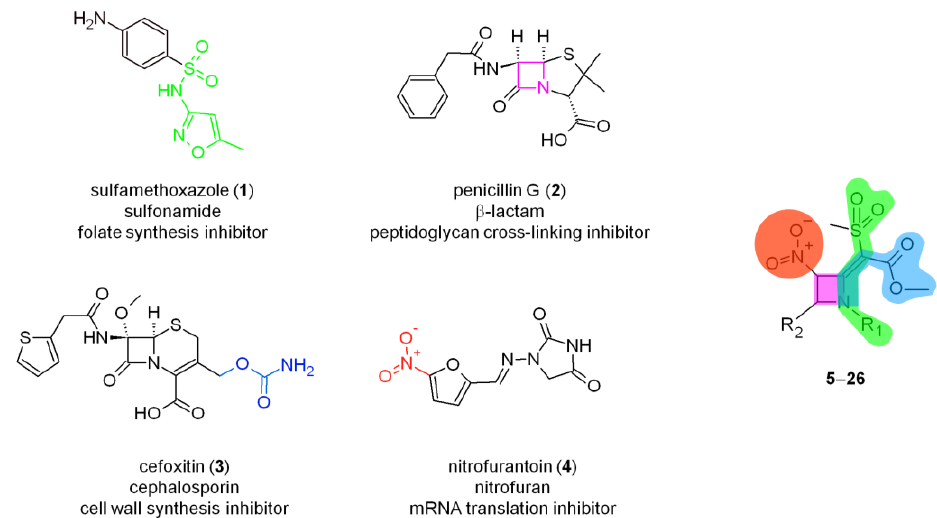
Figure 2. Structures of commonly used antibacterial agents characterized by a sulfonamide group ( 1 ), an azetidine core ( 2 ), a carbamate group ( 3 ) or a nitro substituent ( 4 ), and the general structure for the designed compounds 5 – 26 . Antibacterial classification and mechanism of action were included.